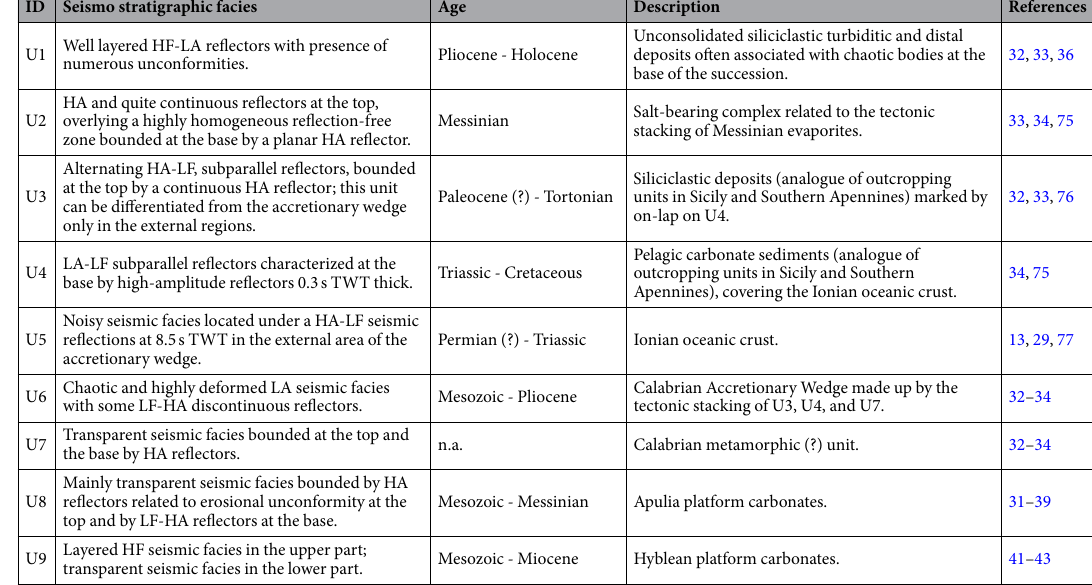
Table 2. Seismo-stratigraphic units. Notes: HA = high amplitude; LA = low amplitude; HF = high frequency; LF = low